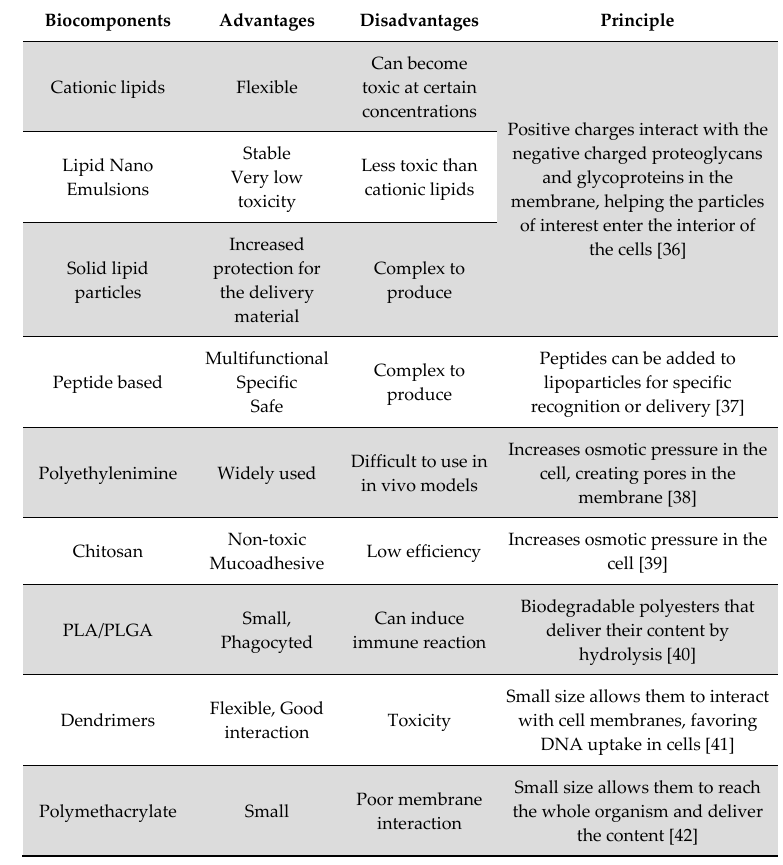
Table 4. Biocomponents used to stimulate DNA insertion into the cells with a summary of the main advantages, disadvantages, and the chemical principle relying on the